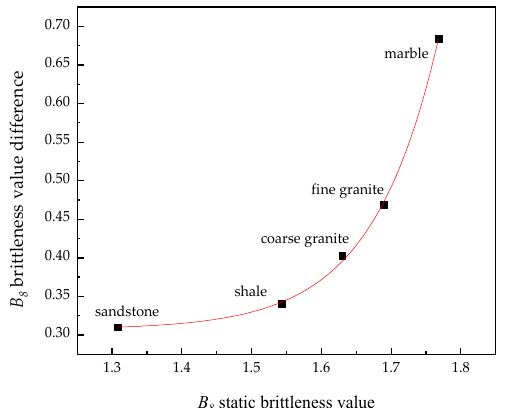
Figure 6. The relationship between the brittleness value difference and the static brittleness value based on B 8 .